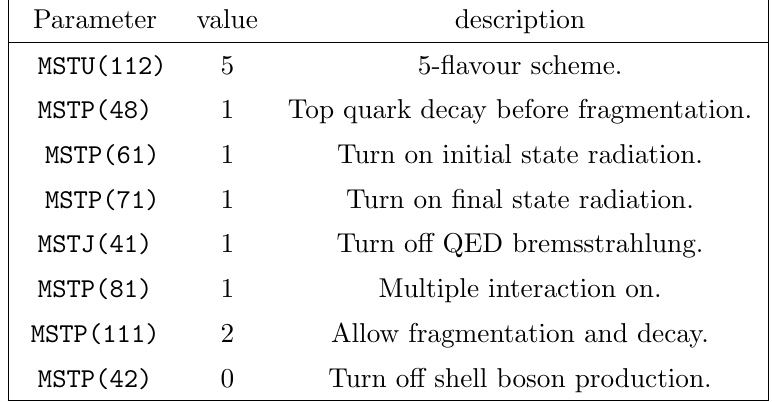
Table 8 . The values of Pythia 6.4 parameters that are changed compared to the default values. Open